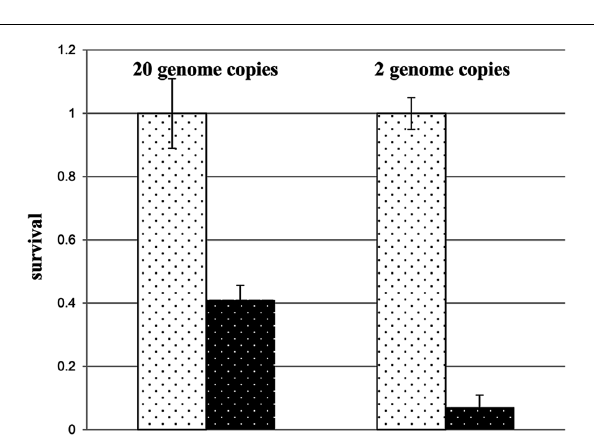
FIGURE 4 | Survival rates of H. volcanii cultures that entered a 12 day desiccation challenge with 20 chromosomes or with 2 chromosomes, as indicated (taken from Zerulla etal.,